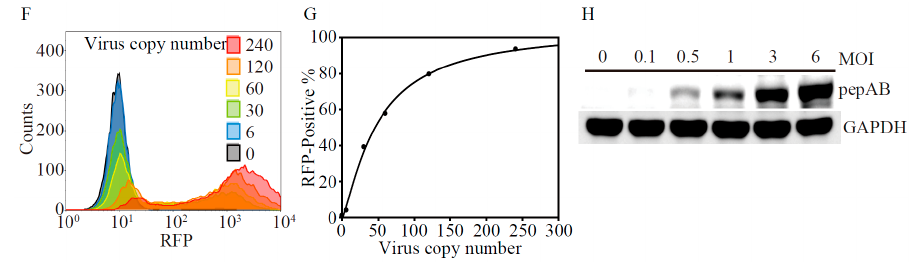
Figure 1. Optimization of virial transduction conditions for human MDA-MB-231 cells ( A ) Schematic representation of the non-invasive apoptosis detection sensor (NIADS). The fusion proteins of pepA-Nluc and pepB-Cluc fragment were linked with 3Xcaspase-3 cleavage sequences (DEVD). Once the cell is undergoing the apoptosis event, activated caspase-3 recognizes the DEVD sequence and cuts the fusion protein into two fragments. The proteins of pepA and pepB are known to have strong association force and therefore enable reconstitution of full-length luciferase. The bioluminescence activity can be further detected with substrate (Luciferin) addition; ( B ) NIADS DNA sequence was cloned into lentivirus plasmid and generated virus particles in medium. The virus titration from 10–40 μ L of both RFP (red fluorescent protein) or NIADS was added in the culture medium of luciferase stable expressing MDA-MB-231 cells for three days. The cells were harvested and immunoblotted to luciferase antibody, whereas the full length of firefly luciferase was determined as protein loading control; ( C ) The virus titration from 10 to 40 μ L RFP virus-containing medium was measured on MDA-MB-231 cells for three days. The image of RFP expression was captured under florescence microscopy. Scale bar: 50 μ M; ( D ) Absolute qPCR analysis was measured by serial copy number of GUS ( β -glucuronidase)-containing TA vector from a range of 10 2 (purple line) to 108 (blue line)/ μ L as a standard curve. The gene amplification curves were also determined for standard error and gene amplification efficiency. The qPCR efficiency analysis for standard curve is calculated by the formula of Efficiency = 10 − 1/slope , whereas qPCR unexplained variance of R 2 value was calculated by the formula of R 2 = 1 − Error; ( E ) The purified and concentrated RFP and NIADS lentivirus were determined as virus copy number/ μ L by absolute qPCR analysis. Data is presented as the mean and standard error; ( F ) The purified and concentrated RFP lentivirus were measured as virus copy number by qPCR analysis. MDA-MB-231 cells were seeded in a 6-cm dish and infected with 6-, 12-, 30-, 60-, 120-, 240-fold concentrations of virus to MDA-MB-231 cell number for three days. The RFP-positive (infected) cell population was assessed using flow cytometry; ( G ) Linear curve comparison of virus input and the RFP-positive cell population; ( H ) The MOI (240-fold as MOI = 1, multiplicity of infection) from 0.1 to 6 of NIADS contain lentivirus were used on MDA-MB-231 cell. The NIADS fusion protein was immunoblotted by luciferase antibody.